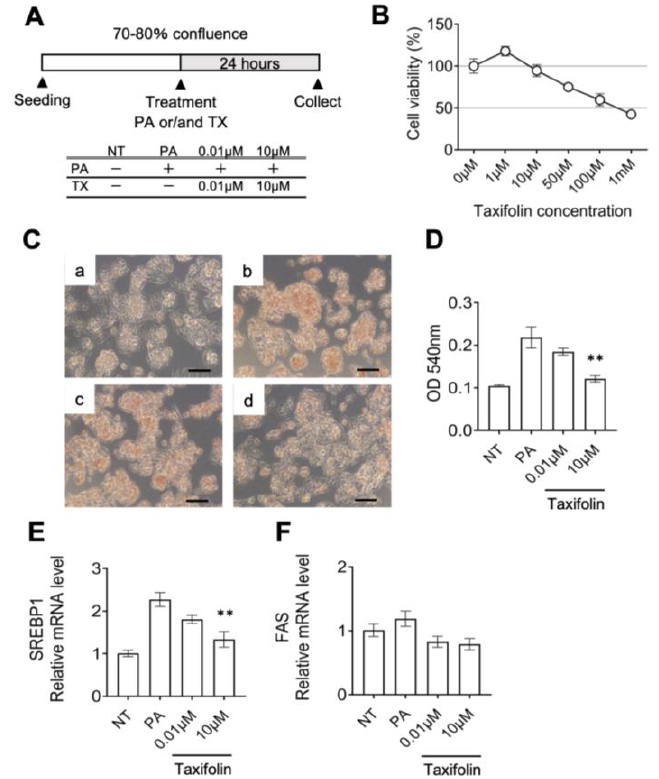
Figure 6. Direct action of Taxifolin on hepatocytes. ( A ) Experimental protocol: HepG2 cells were treated with Taxifolin (0.01 and 10 µ M) for 24 h in the presence of palmitate (400 µ M). ( B ) Cell viability after treatment with Taxifolin (1, 10, 50, and 100 µ M and 1 mM) for 24 h. ( C , D ) Representative image of Oil Red O staining ( C ) and its quantitative evaluation measuring the absorbance at 540 nm ( D ). HepG2 cells were treated with vehicle ( a ), palmitate 400 µ M ( b ), and palmitate with 0.01 µ M ( c ) or 10 µ M ( d ) Taxifolin for 24 h. Scale bars: 100 µ m. E and F : Expression levels of SREBP1 ( E ) and FAS ( F ) mRNAs in the HepG2 cells. Values are presented as the means ± SEM; n = 3; significant differences: ** p < 0.01 vs. palmitate.